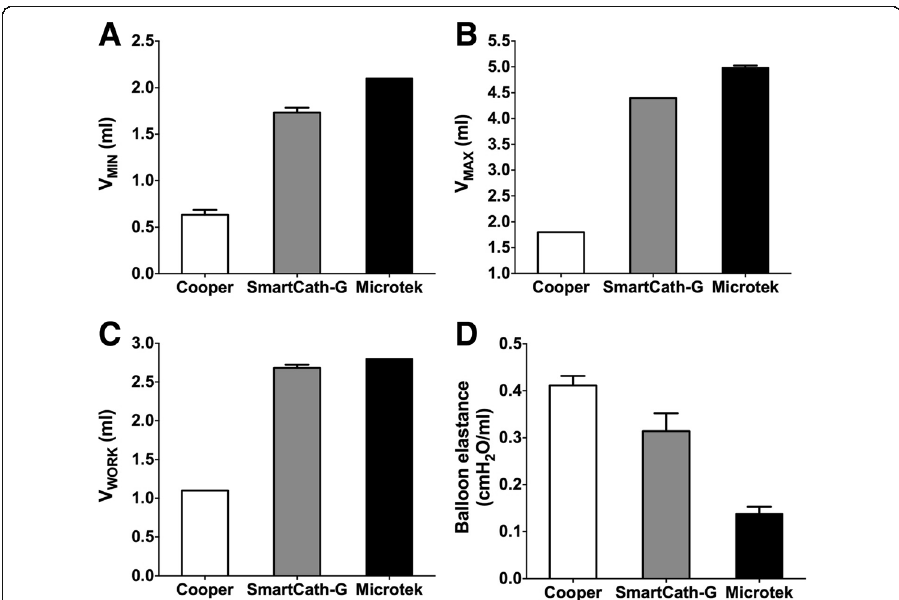
Fig. 3 a – d Balloon volume data and balloon elastance at atmosphere. Data are shown as mean and standard deviation. Significant difference existed in minimal ( V MIN , a ), maximal balloon inflating volume ( V MAX , b ), working volume ( V WORK , c ), and balloon elastance across different balloons ( p < 0.001, d ). All p values are <0.001